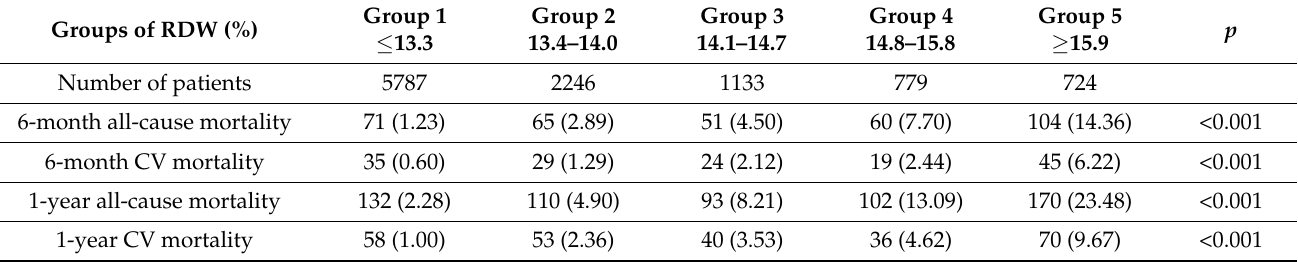
Table 2. Mortality Outcome of Study Patients stratified by Quintiles of Red Cell Distribution